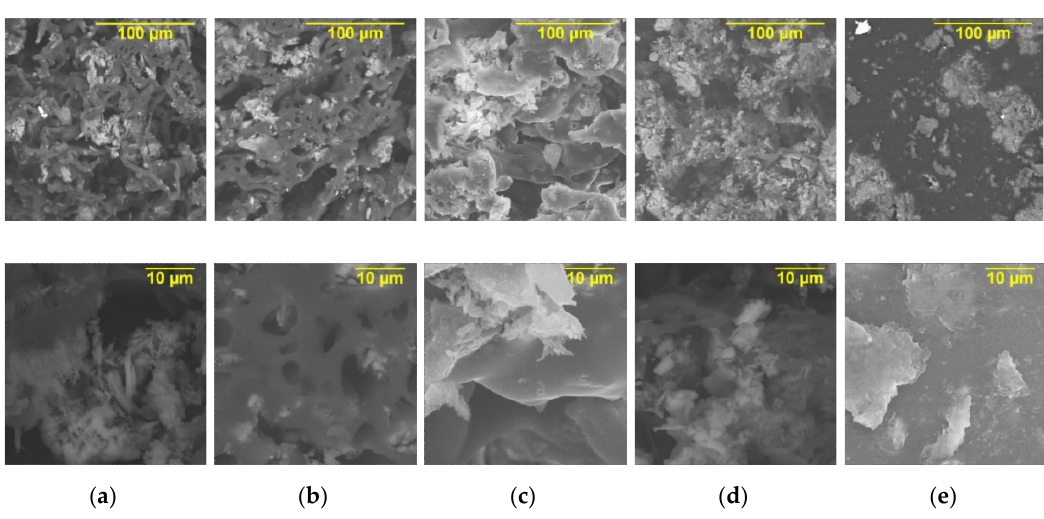
Figure 3. The microphotographs of the composites obtained by SEM: ( a ) sample 1/6-70-30 based on 70 wt.% of PVB and 30 wt.% of PPT, IPA/water = 1:5; ( b ) sample 1/4-70-30 based on 70 wt.% of PVB and 30 wt.% of PPT, IPA/water = 1:4; ( c ) sample 1/2-70-30 based on 70 wt.% of PVB and 30 wt.% PPT, IPA/water = 1:2; ( d ) sample 1/4-50-50 based on 50 wt.% of PVB and 50 wt.% of PPT, IPA/water = 1:4; ( e ) sample 1/4-90-10 based on 90 wt.% of PVB and 10 wt.% of PPT, IPA/water = 1/4. Abbreviations: